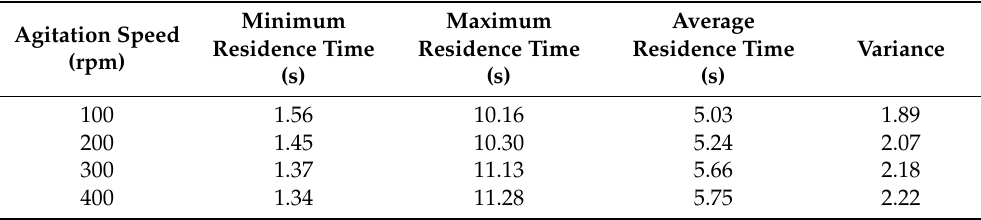
Table 3. Bubble residence time at different agitation speeds.